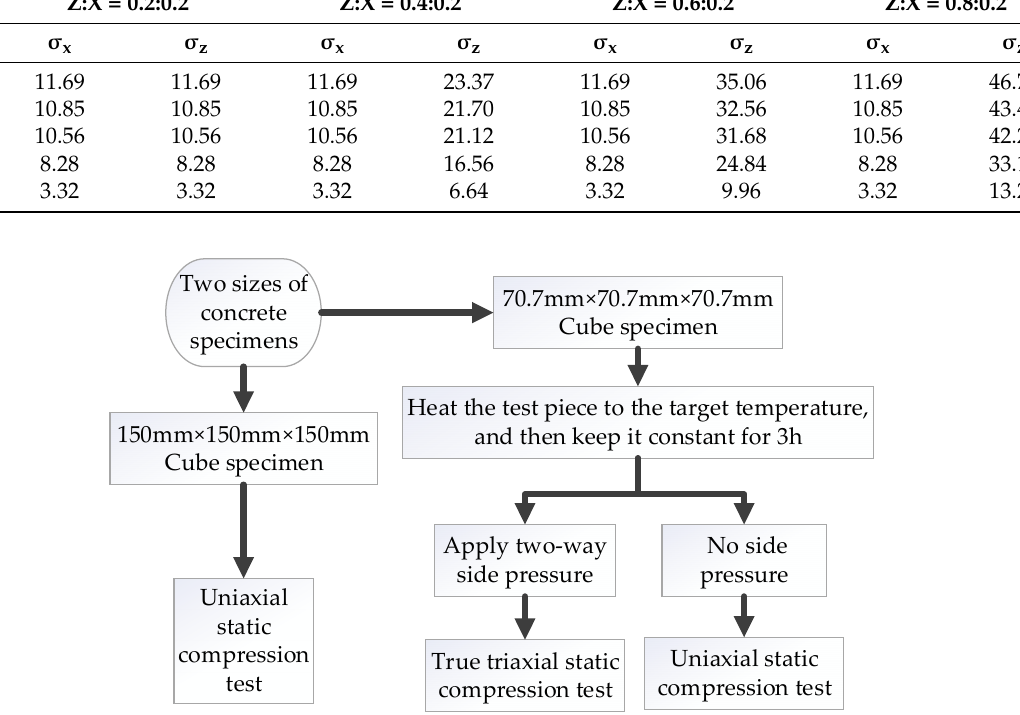
Figure 4. Test flow chart.